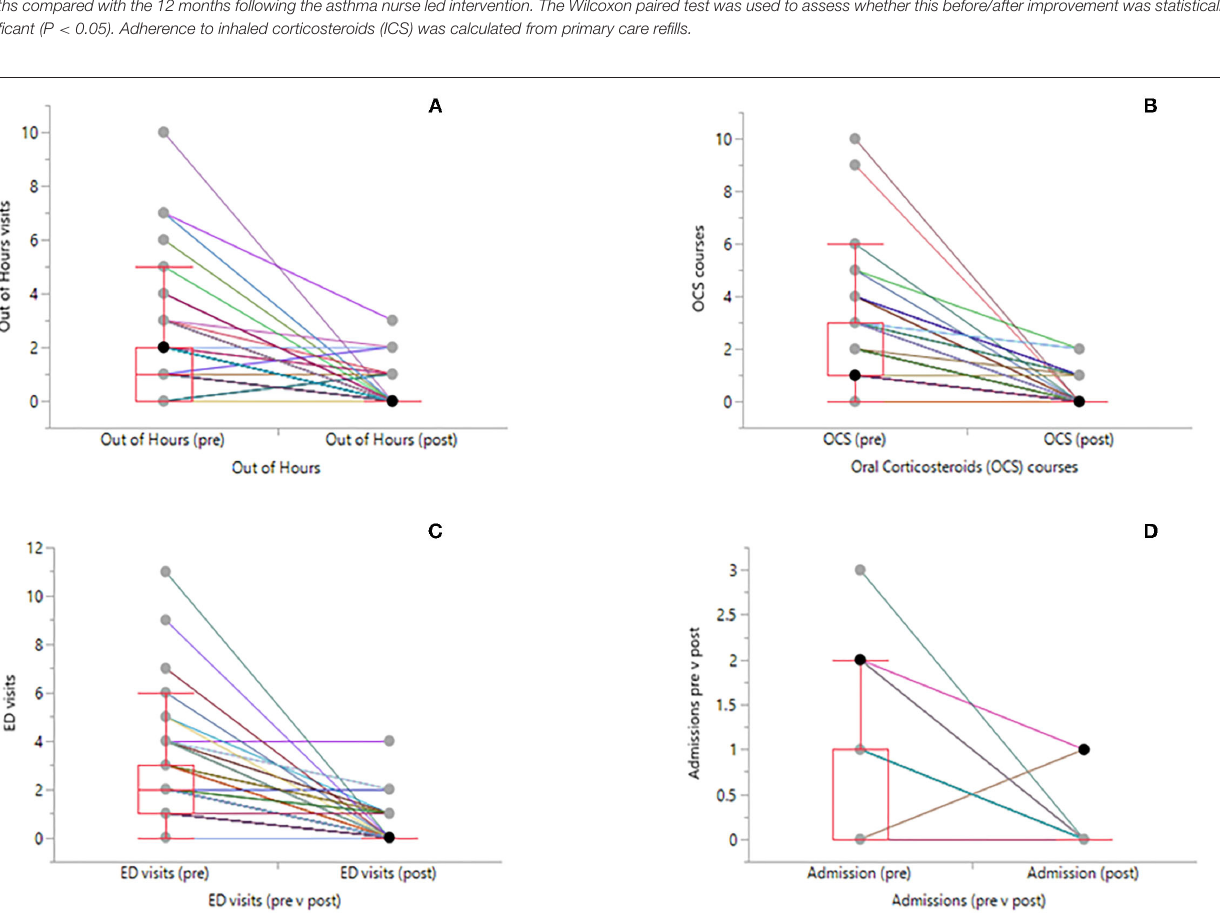
FIGURE 2 | Before and after Box plots with individual patients linked by solid lines. On the y-axis are number of OoH visits (A) , number of courses OCS (B) , number of ED visits (C) and number of admissions (D) . The center horizontal line in the box is the median, the upper horizontal box lines are the quartiles and dots above the upper whisker represent individual